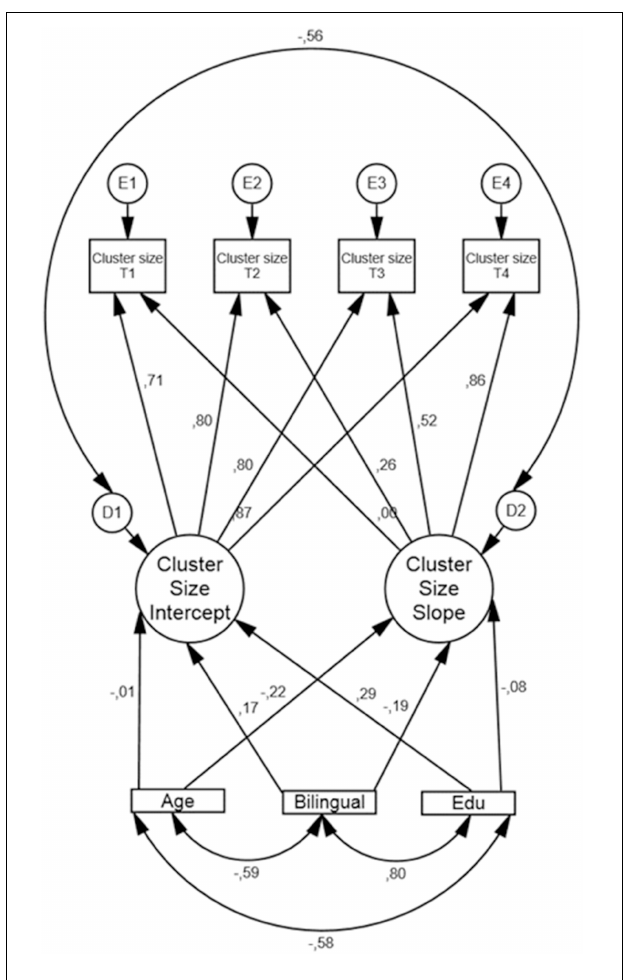
FIGURE 4 | Conditional LGM of cluster size with bilingualism, age, and education as covariates along with standardized regression weights. Edu = years of formal schooling, Bilingual = (coded as 1 = yes and 0 =